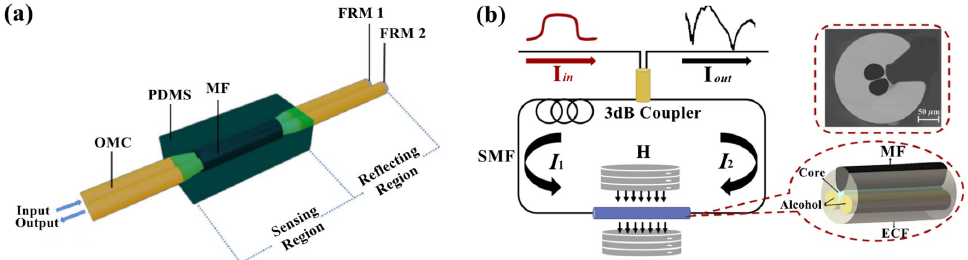
Figure 5. Magnetic field fiber sensors based on ( a ) MI (reprinted with permission from Ref. [43], 2021, The Optical Society) and ( b ) SI (reprinted with permission from Ref. [44], 2022, The Optical Society).